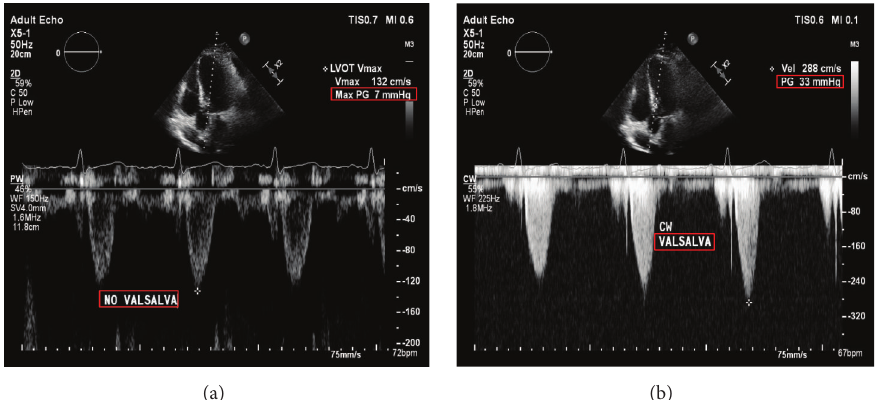
Figure 4: Postoperative Transthoracic Echocardiogram demonstrating resting left ventricular outflow tract pressure gradient of 7mmHg (a) and a pressure gradient of 33 mmHg on Valsalva (b).